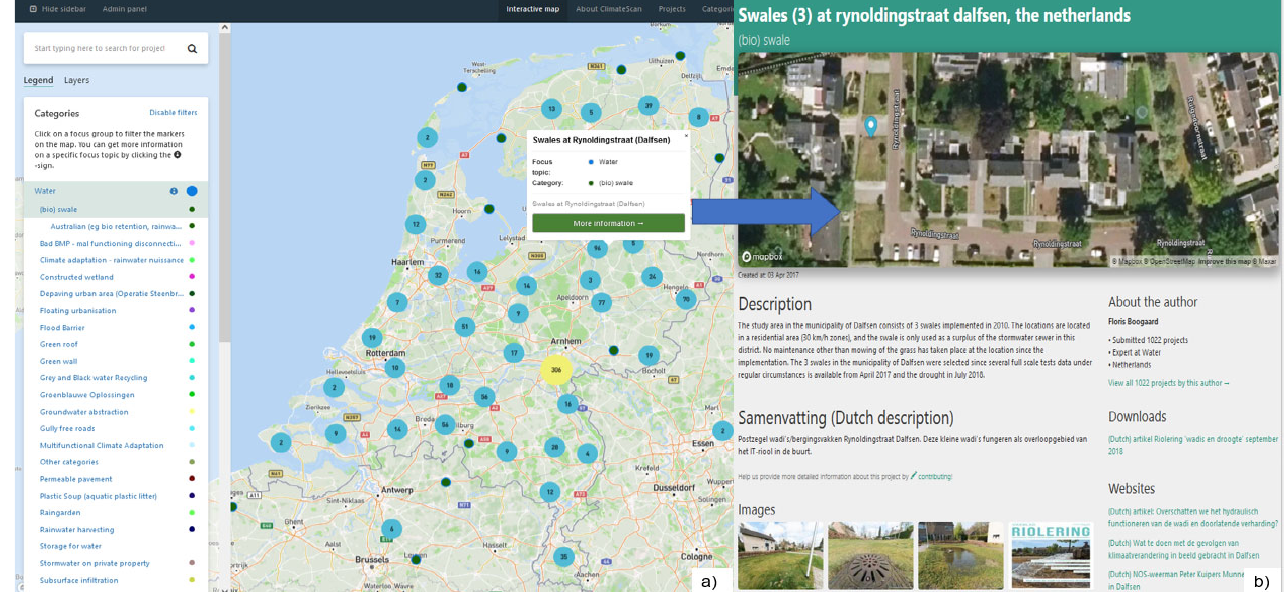
Figure 2. ( a ) Aggregated map of The Netherlands with over 1000 locations installed Dutch swales (Source: ClimateScan. Available online: https://www.climatescan.nl/map#filter ‐ 1 ‐ 1 (accessed on 1 January 2022)). ( b ) Exact location of 3 swales in the Reynoldstraat in Dalfsen (more information: ClimateScan. Available online: https://www.climatescan.nl/projects/1114/detail (accessed on 1 January 2022)).